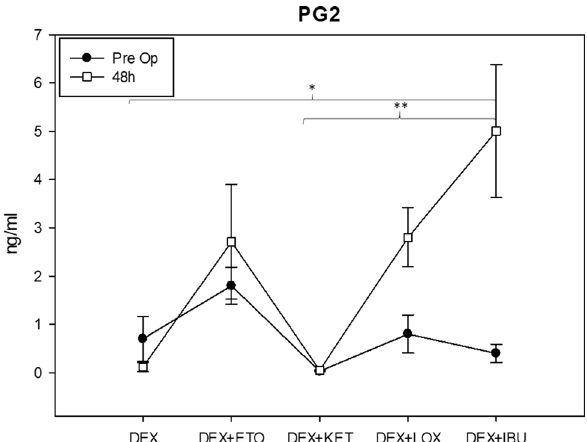
Figure 5. Chart regarding prostaglandin salivary E2 (PGE2) concentration. Data showed that DEX group was the only which decreased the PGE2 at 48 h postoperative (80%), while other groups showed an increase of PGE2 concentration at 48 h postoperative. *The value indicated significant differences between the DEX and DEX + IBU groups ( P < 0.05—Tukey test). ** The value indicated significant differences between the DEX + KET and DEX + IBU groups ( P < 0.05—Tukey